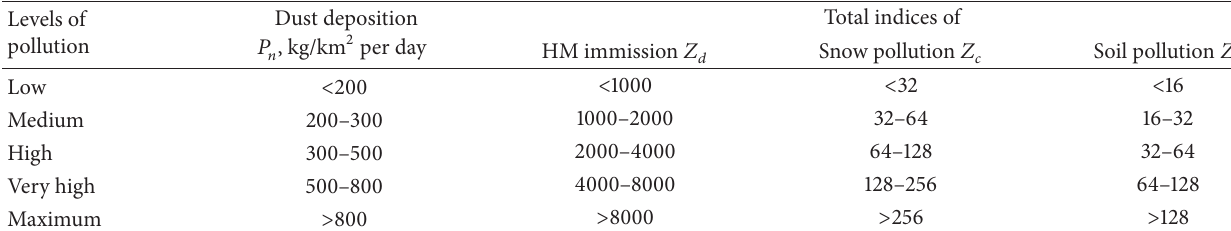
Table 1: Levels of landscape pollution with HMs and dust [14].